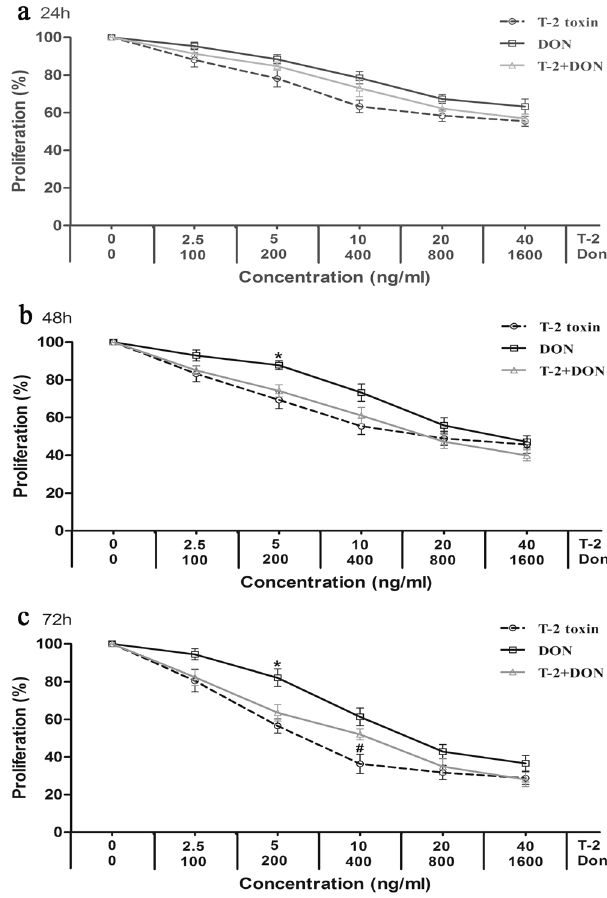
Figure 1. Cytotoxicity of T-2 toxin and/or DON in the cartilage-derived cell line, C28/I2. Cells in 96-well plates were exposed to five dilutions of T-2 toxin (from 2.5 to 40 ng/ml) or DON (from 100to 1600 ng/ml), or a fixed constant ratio of the two mycotoxins (T-2 + DON, ratio = 1:40). After ( a ) 24 h, ( b ) 48 h and ( c ) 72 h of exposure, the cell viability was analyzed by the MTT assay. Each data point represents the mean ± SEM from three independent experiments with replicate samples, * p < 0.05 indicates significant differences between the mixture and T-2 toxin alone, # p < 0.05 represents significant differences between the mixture and DON